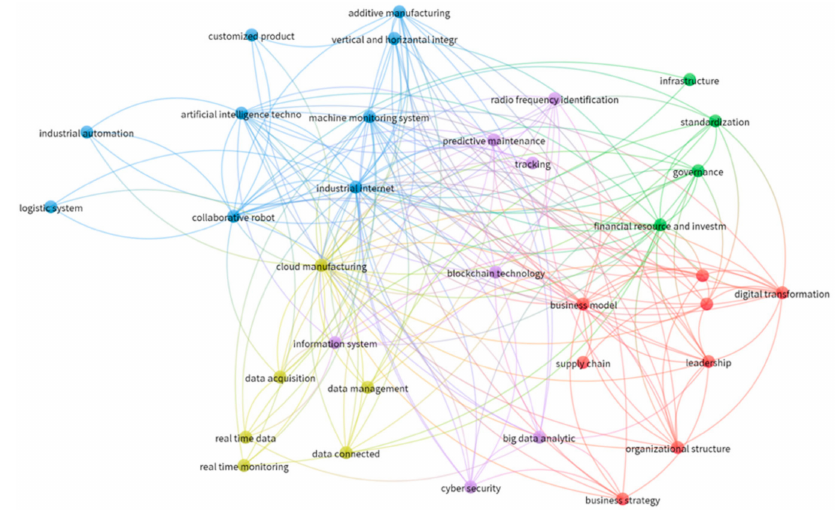
Figure 2. Industry 4.0 Aspects relationship from visualization of similarities mapping.